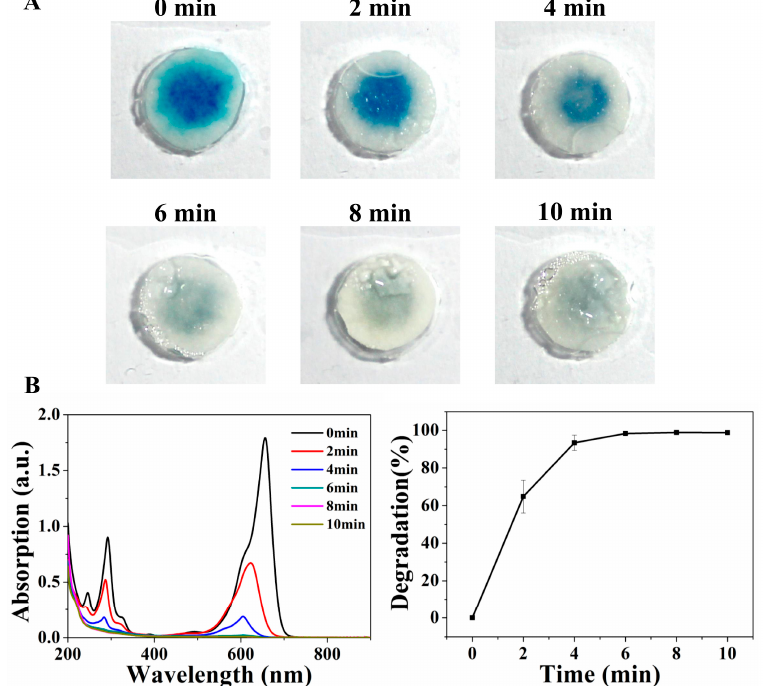
Figure 3. Degradation results of the paper based method. ( A ) The blue color obviously changed after illumination (0–10 min). ( B ) The corresponding UV-vis spectra and the degradation rate. Each test was repeated three times.